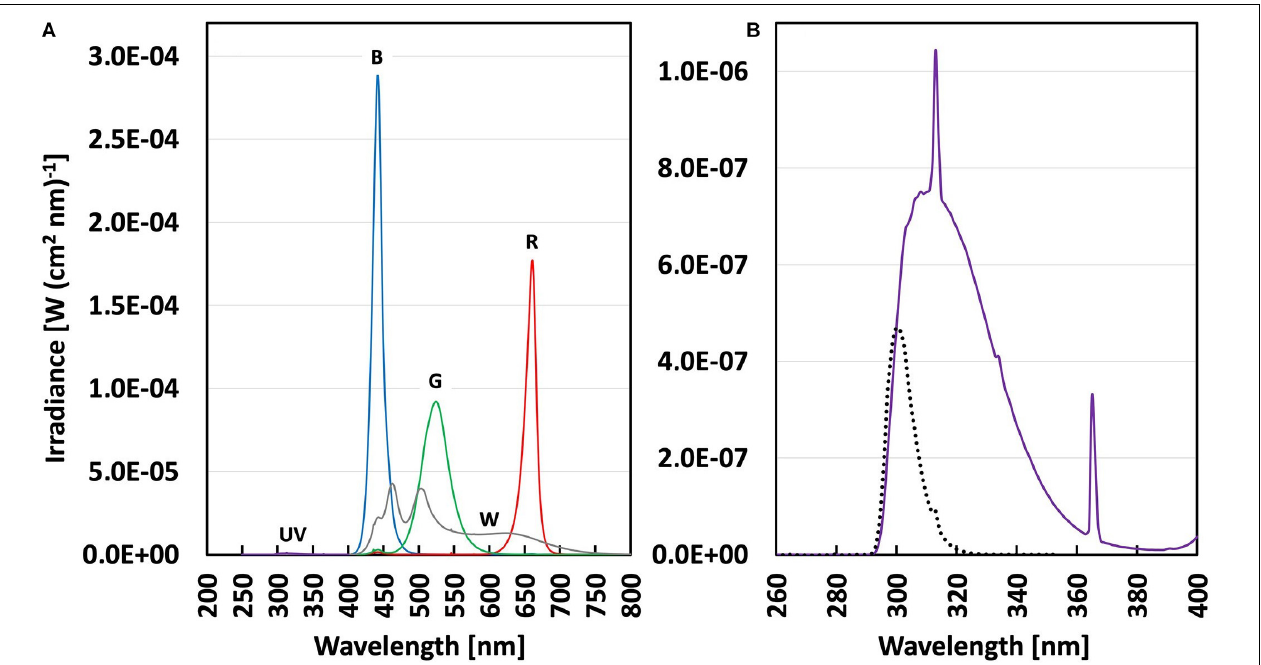
FIGURE 1 | (A) Spectral irradiance (in W(cm 2 nm) − 1 ) in Perspex covered (control) and cellulose acetate covered (UV-B) boxes under four different PAR backgrounds ( Table 1 ); broadband White (gray line), Blue, Green, Red (with lines of respective color) and UV-B (violet line). (B) Spectral irradiance in the UV range (violet line) with enlarged scale and the plant-weighted UV dose (black dotted line) in the UV-B